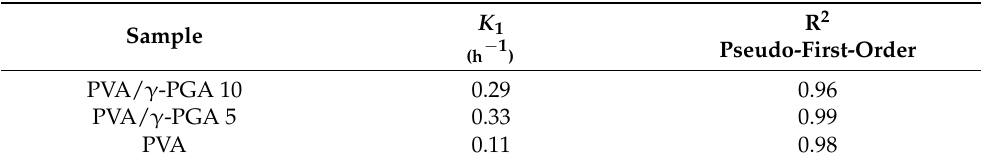
Table 1. Rate constants ( K 1 ) and correlation coefficients (R 2 values) of PVA, PVA/ γ -PGA 5, and PVA/ γ -PGA 10.